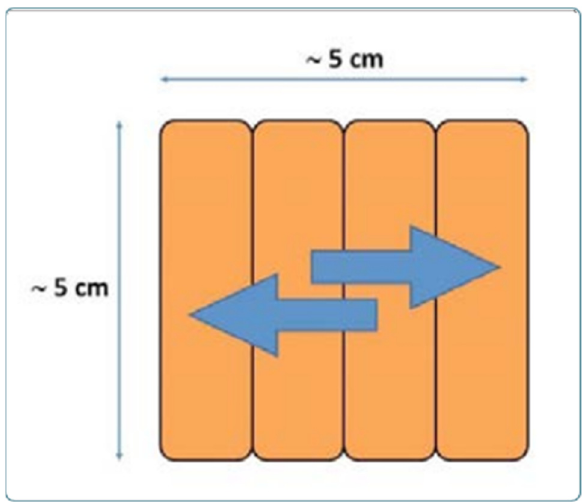
Figure 1. Graphical representation of the “in-motion” technique. Courtesy of DEKA M.E.L.A company.